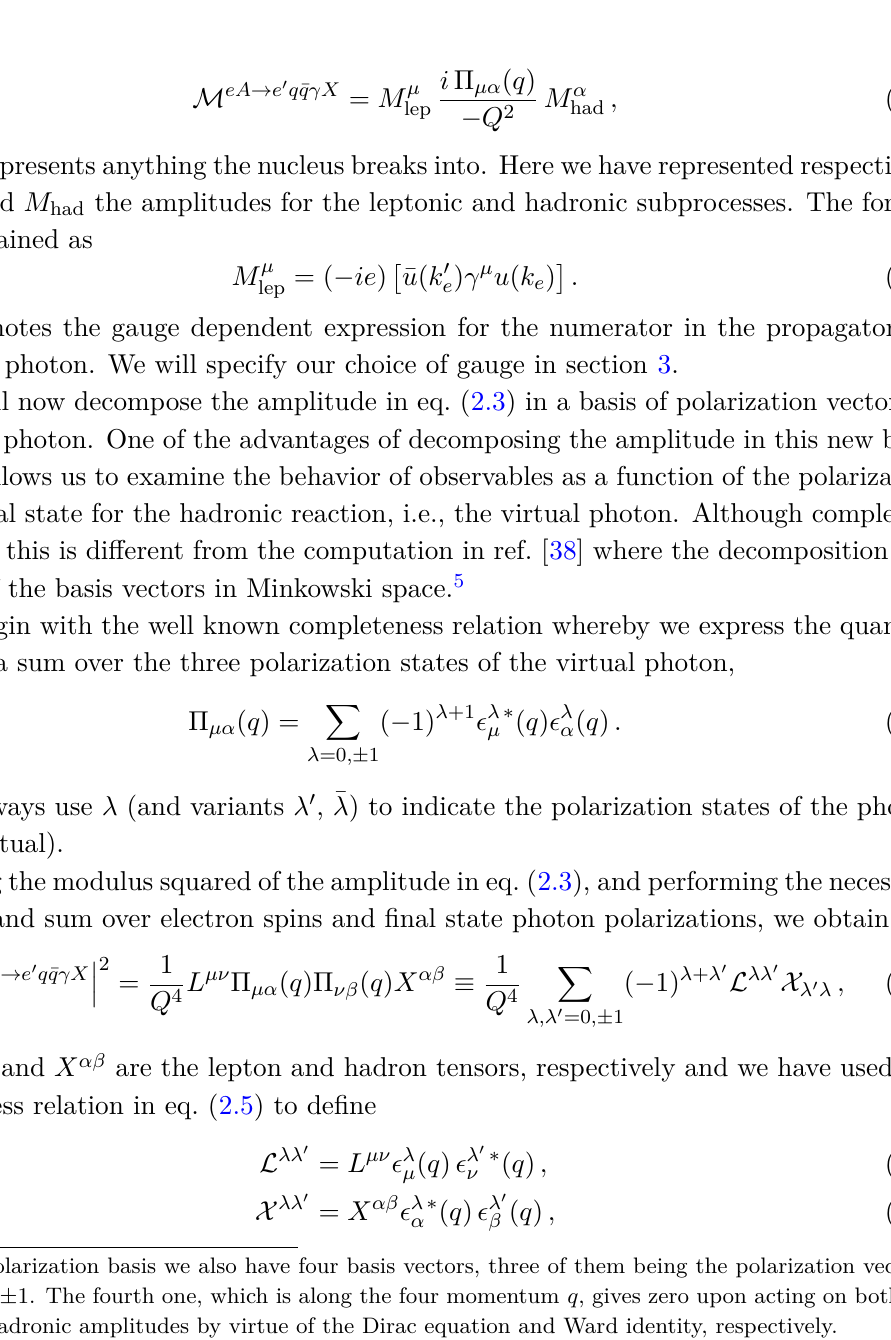
Table 1 . 4-momentum assignments used in the